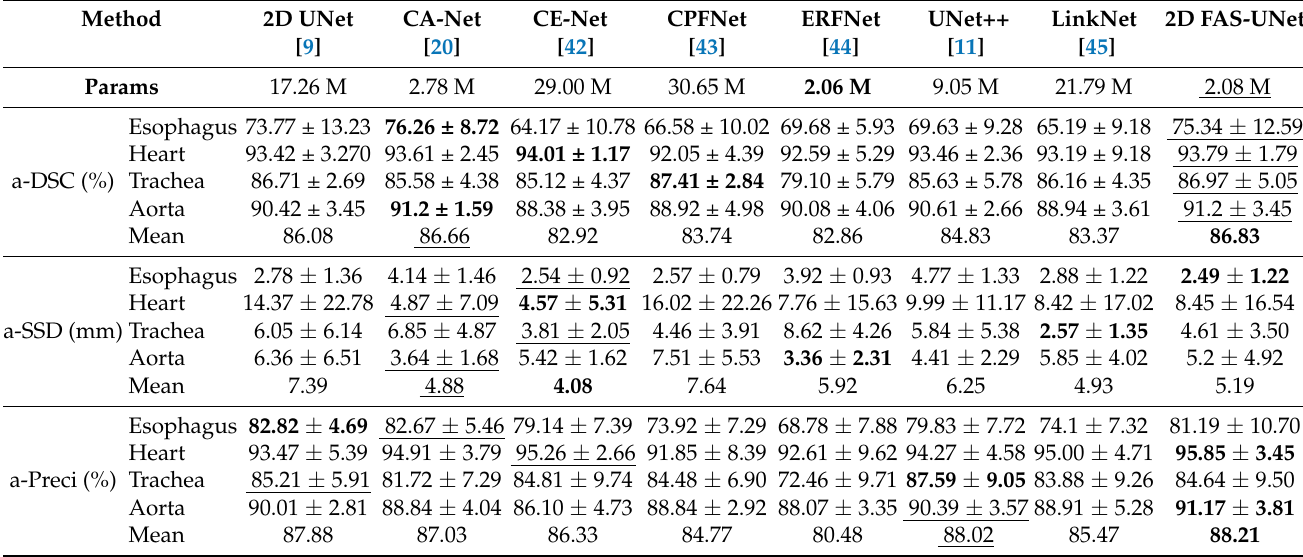
Table 7. Performance comparisons between the proposed 2D FAS-UNet and the popular networks using the a-DSC, a-SSD, and a-Preci values on the 2D SegTHOR validation datasets with four organs: esophagus, heart, trachea, and aorta. “Mean” denotes an average score segmenting all organs. The best and second places are highlighted in bold font and underlined, respectively.